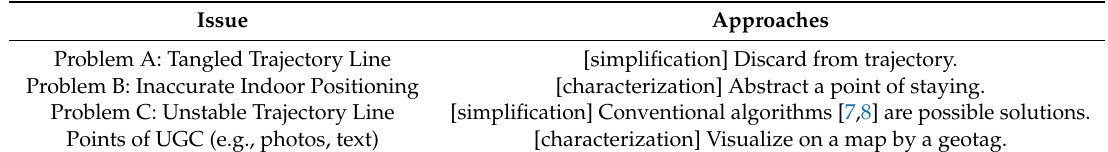
Table 1. Correspondence table between issues needing resolution and our conceptual approaches.